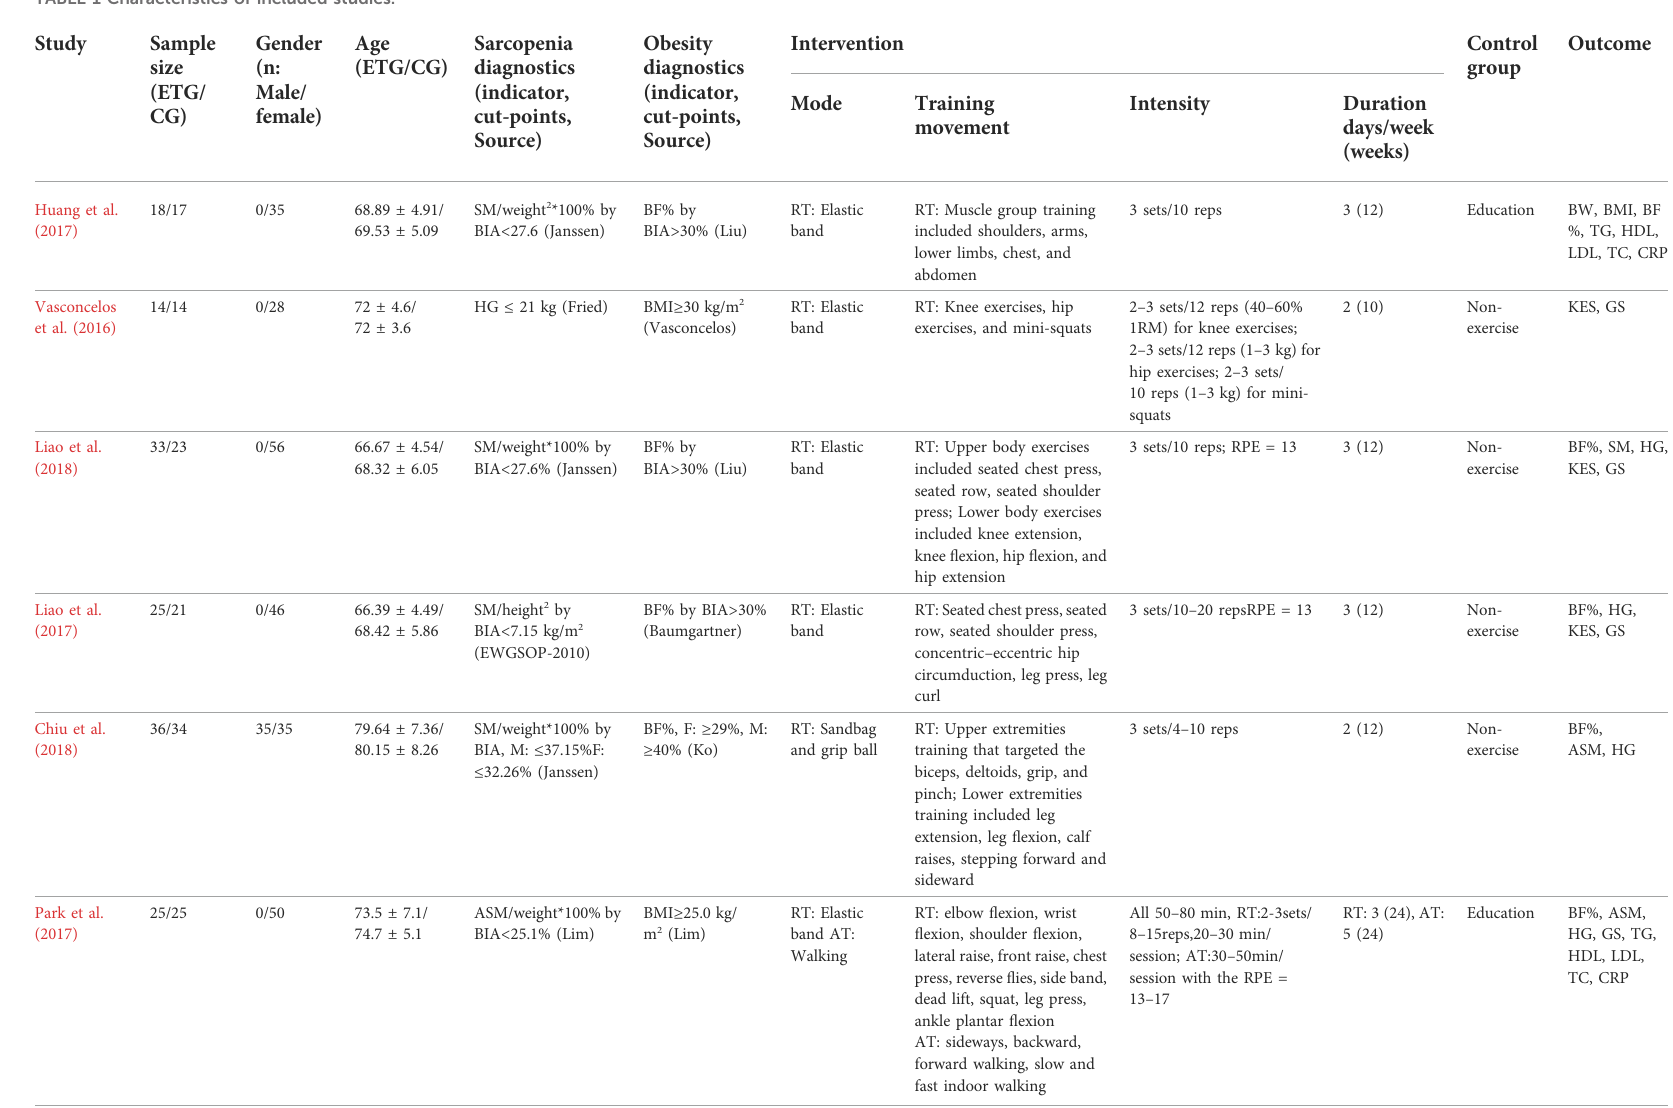
TABLE 1 Characteristics of included